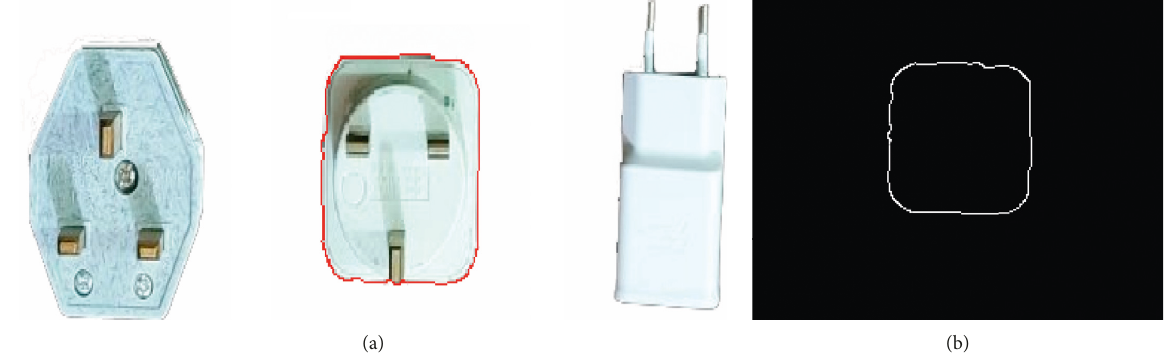
Figure 8: The matching of sample 2: (a) product image captured; (b) template image.